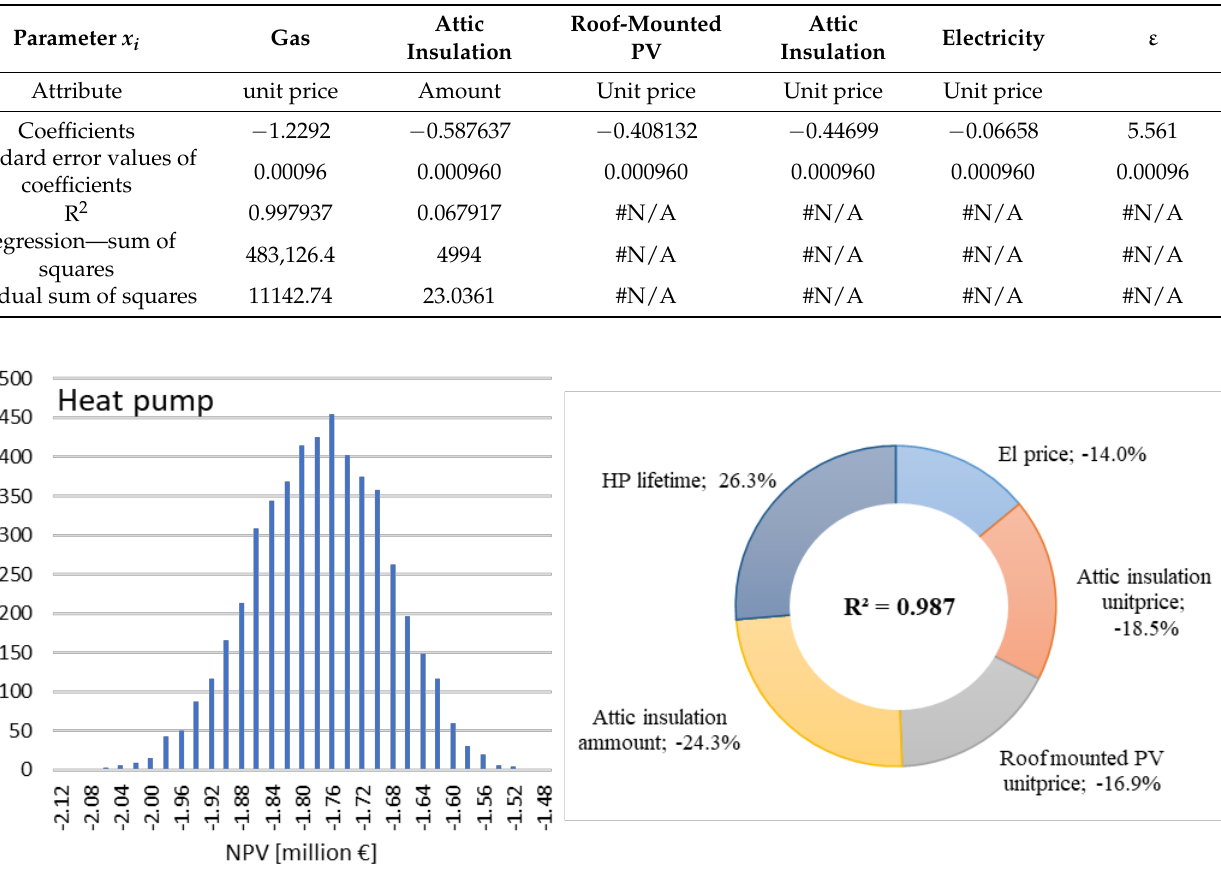
Figure A3. Left: histogram representation of resulting NPV for heat pump. Right: resulting share of regression coefficients and R 2 value of the linear approximation. Table A3. Regression parameters for calculation model with heat pump.